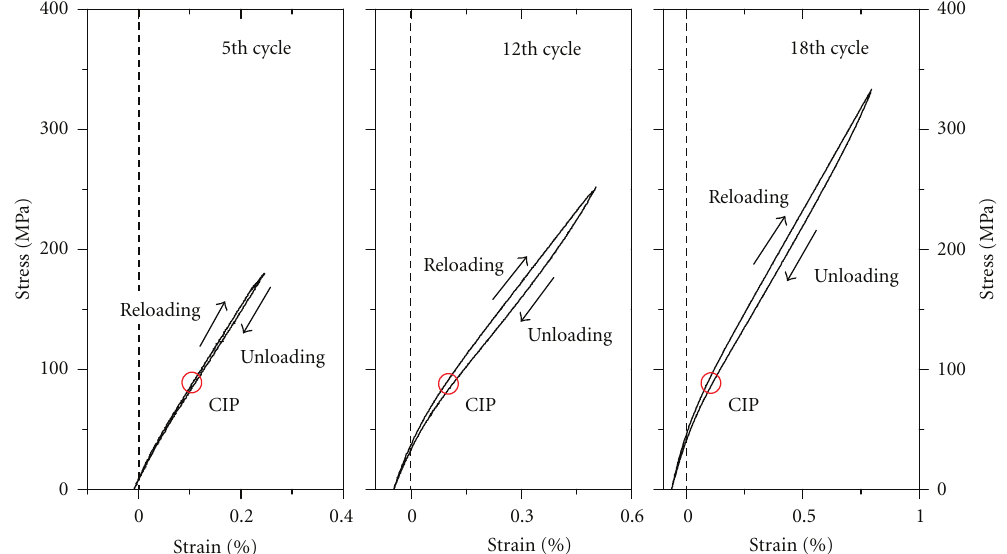
F 4: Evolution of hysteresis loop shape in the elastic, damage and stiffening regimes.